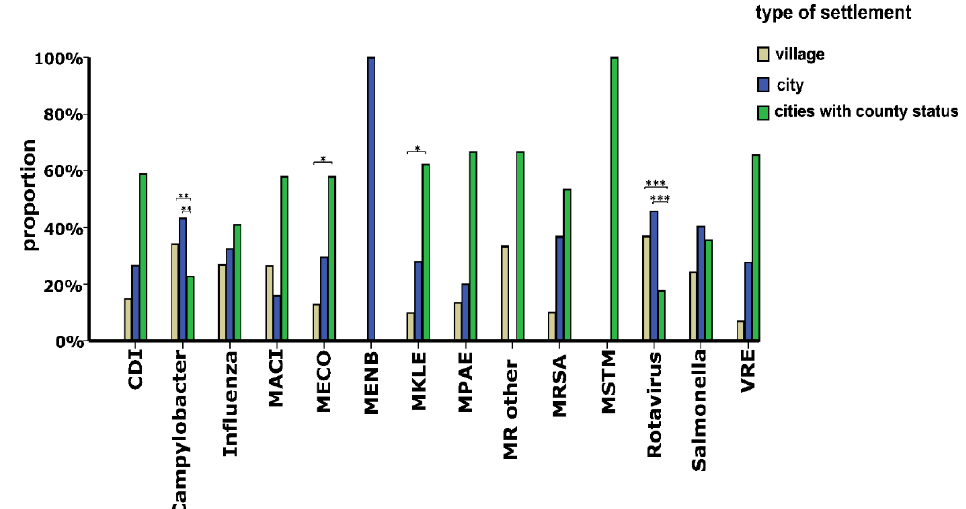
Figure 5. Distribution of patients with community-acquired infections detected at the University of Debrecen Clinical Centre Nagyerdei Campus in 2020 by place of residence. Place of residence was categorised as village, city and cities with county status (see the details on settlement categories in Section 2.2). Abbreviations: CDI: Clostridioides difficile , MRSA: Methicillin-resistant Staphylococcus aureus , MECO: Multidrug-resistant Escherichia coli , MKLE: Multidrug-resistant Klebsiella spp . , MPAE: Multidrug-resistant Pseudomonas aeruginosa , MACI: Multidrug-resistant Acinetobacter bau- mannii , MENB: Multidrug-resistant Enterobacter spp . , MSTM: Multidrug-resistant Stenotrophomonas maltophilia , MR OTHER: Other Multidrug-resistant organisms ( Proteus mirabilis , Citrobacter freundii,